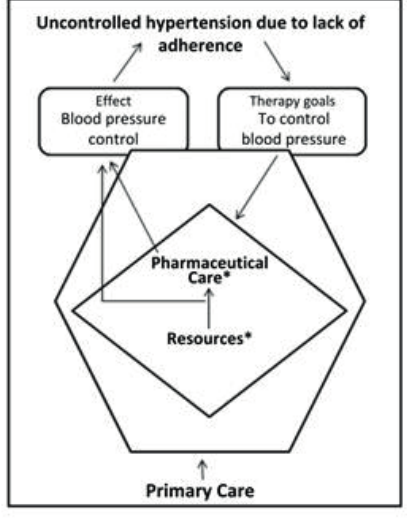
FIGURE 4 - Schematic illustration of intervention on the problem situation in the primary care